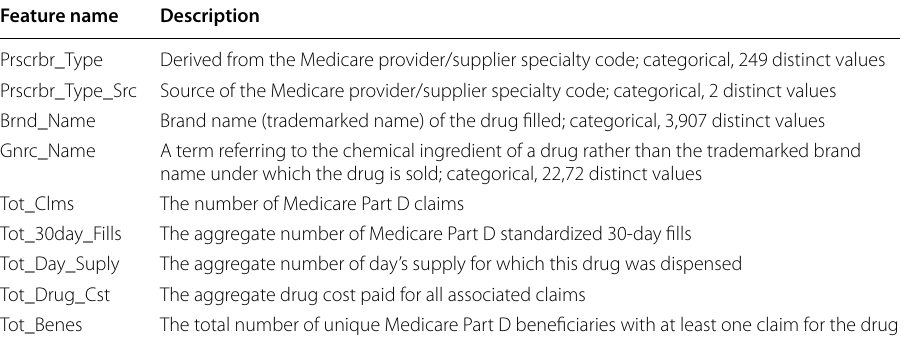
Table 3 Features of the Part D